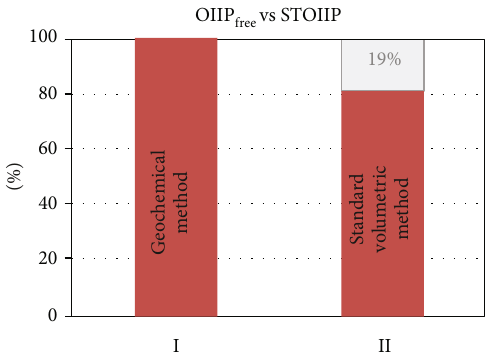
Figure 12: Comparison of the free oil-in-place estimation results obtained with geochemical and standard volumetric methods for Sasino formation; average oil-in-place quantities per square km of the study area were compared, taking the result of geochemical method as the reference